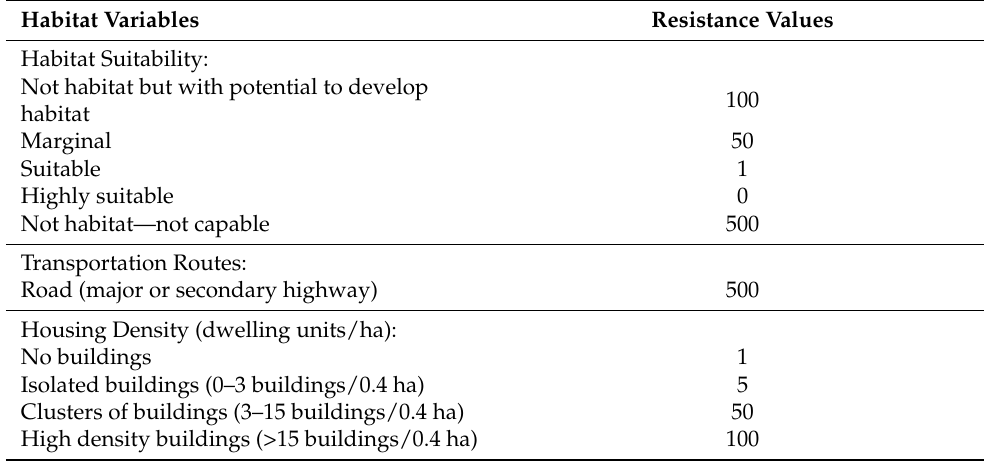
Table 3. Habitat variables and resistance values used to evaluate dispersal habitat suitability for red tree voles ( Arborimus. longicaudus ) in the evaluation area in Oregon and California, USA. Habitat